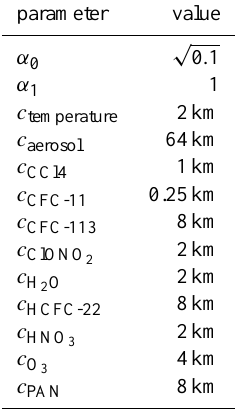
Table 2. Parameters employed for the regularisation: Tikhonov strength and correlation lengths.